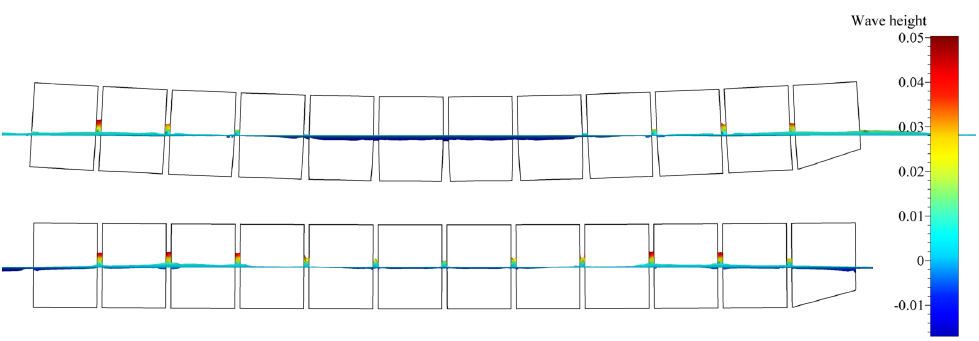
Figure 7. Profile view of free-surface elevation along the barge’s length for the first mode of vertical